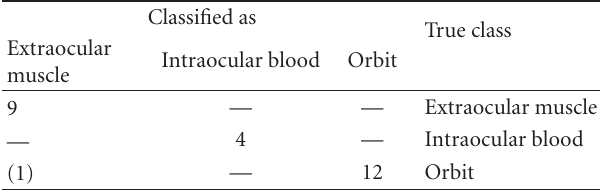
Table 2: Results of automatic tissues di ff